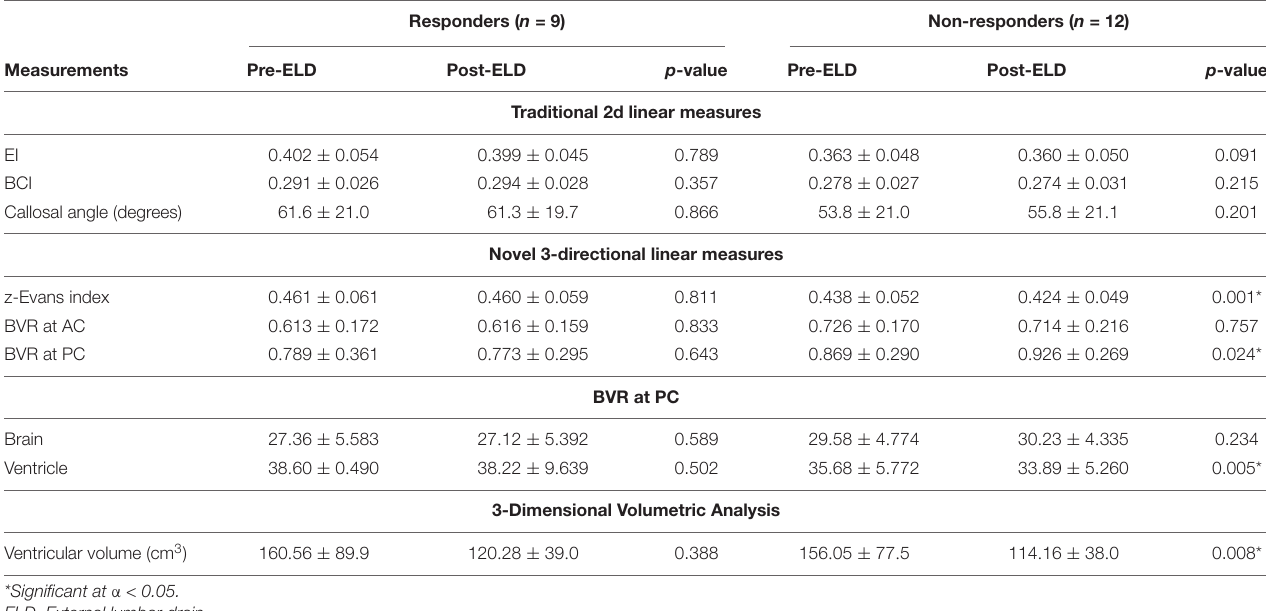
TABLE 7 | Classification of normal pressure hydrocephalus (NPH) cohorts by Responsiveness to CSF drainage: Morphological indices within groups compared at baseline vs. post-lumbar